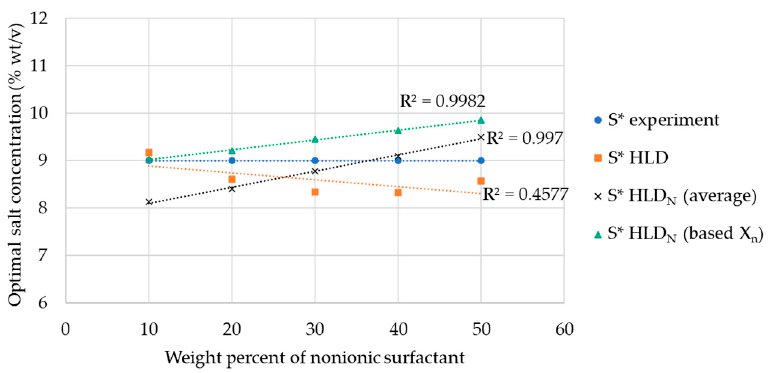
Figure 9. Optimal salt concentrations (S*) from the HLD, and HLD N prediction of SDHS- AAE(6EO4PO) systems for commercial diesel (EACN = 9.10).